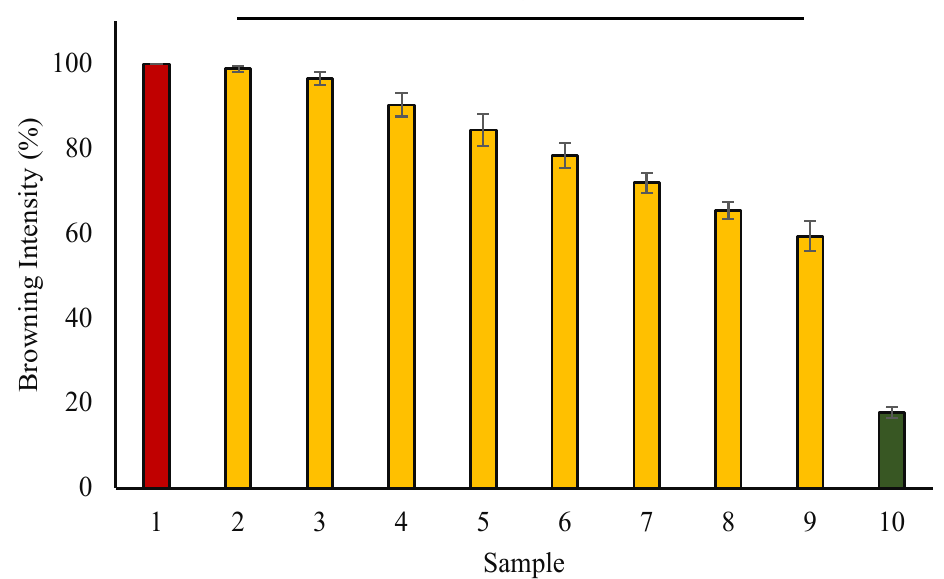
Figure 6. Decrease in browning in presence of myrrh. Sample 1 denotes BSA having glucose and kept for 15 days and is thought to have 100% glycation (or browning). Samples 2 to 9 contained 50, 75, 100, 200, 300, 400, 500, and 600 µ g/mL of myrrh. With an increase in myrrh concentration, the browning intensity (or potentially glycation) is revealed to be declining. Sample 10 contained BSA alone and it exhibited minimal browning intensity that might be due to some structural changes. The data are shown as means ± standard error of the means (n = 3, p < 0.05). The statistical differences are represented with an asterisk (*) for myrrh denoting significance at p < 0.05 in comparison with the reference